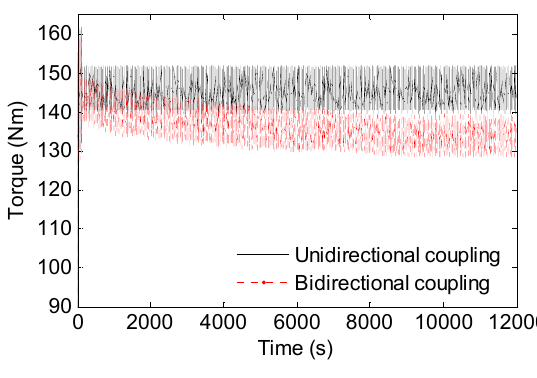
Figure 19. Torque Figure 19. Torque evolutions. Figure 19. Torque evolutions.